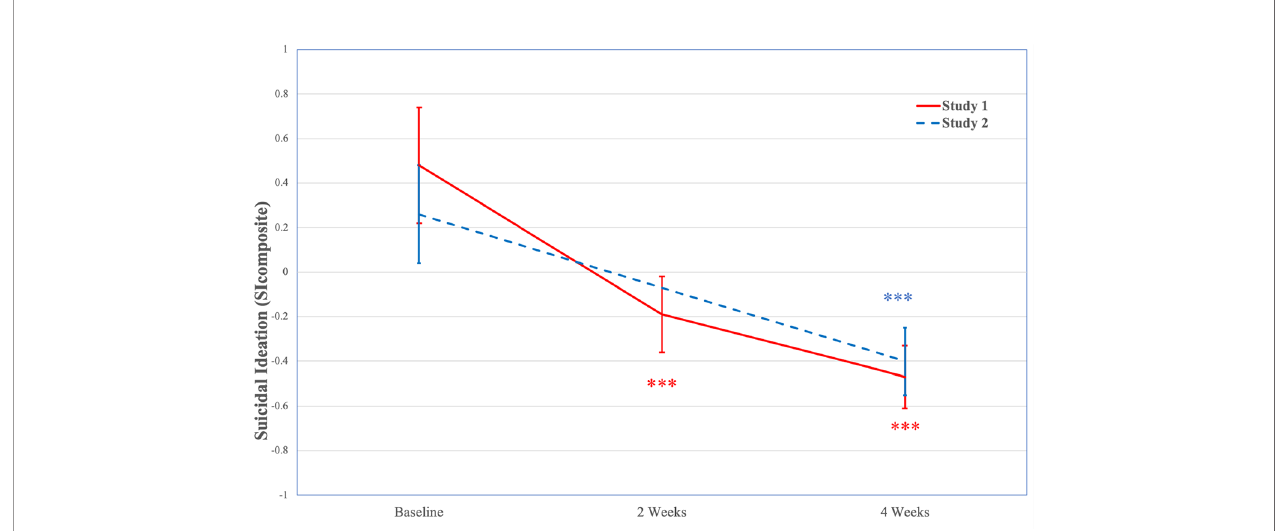
FIGURE 3 | Decreases in Suicidal Ideation (SI composite ) Over Time (Study 1 and Study 2). Note. Study 1 N =104; Study 2 N =254; SI composite is only assessed at baseline and 4-weeks in Study 2; *** p < .001. SI composite , composite measure of suicidal